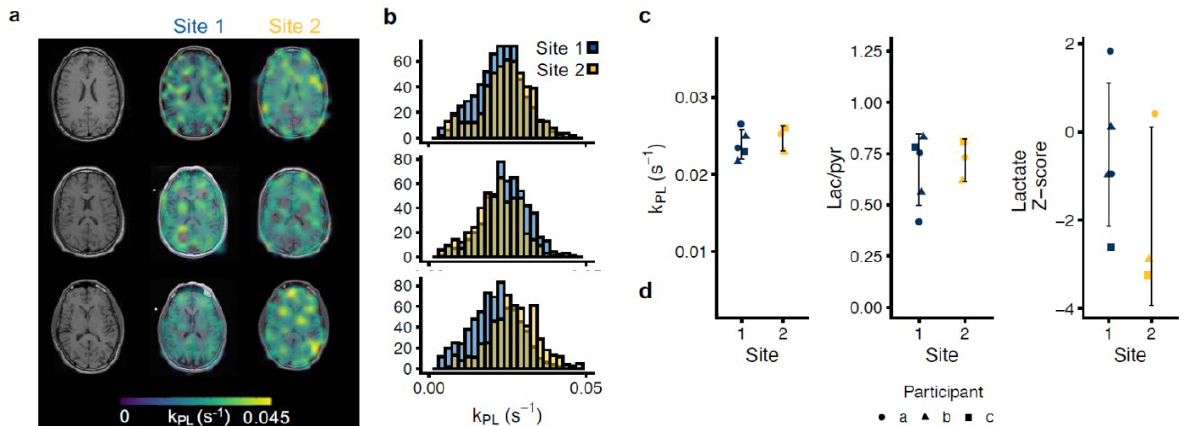
Figure 3. Multisite repeatability of hyperpolarized [1- 13 C]pyruvate MRI. Imaging was performed at two sites under the same protocol (two individuals scanned three times and one scanned twice).